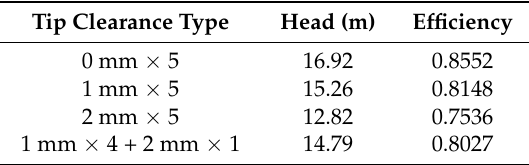
Table 3. Energy performances of pumps with different tip clearances.